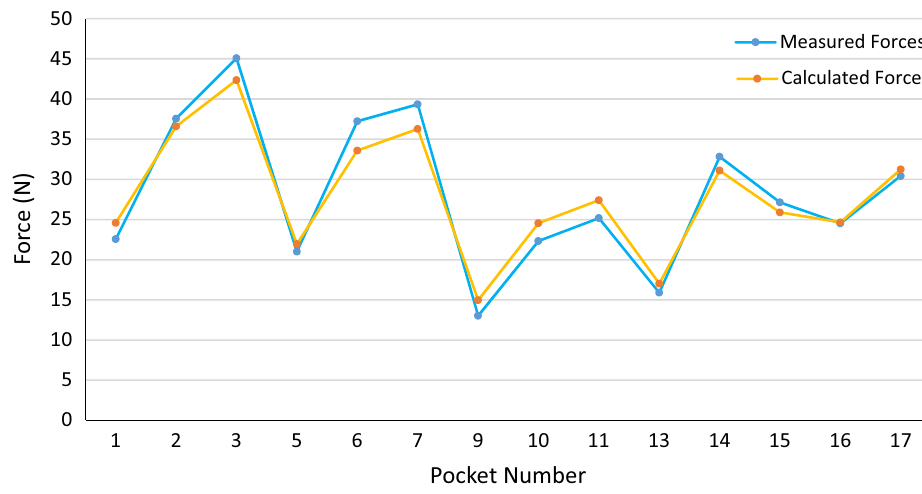
Figure 14. Measured and calculated push-out forces in PPA cages.